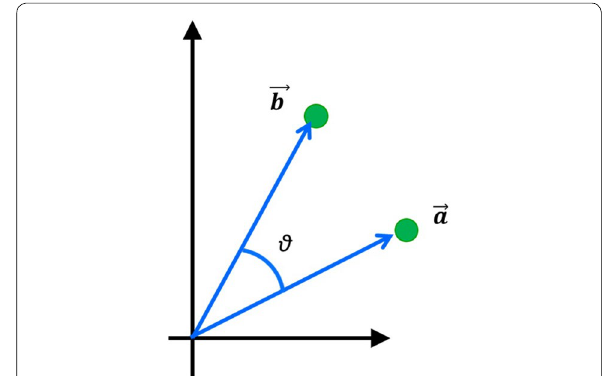
Fig. 5 Angle between solutions in the error